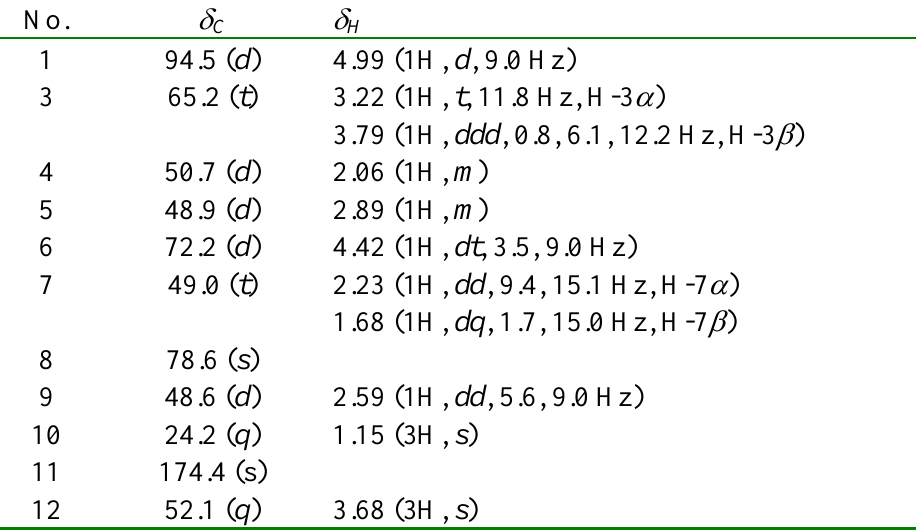
OD. ( 1 H- at 400 and 13 C- at 100 MHz; J in 3